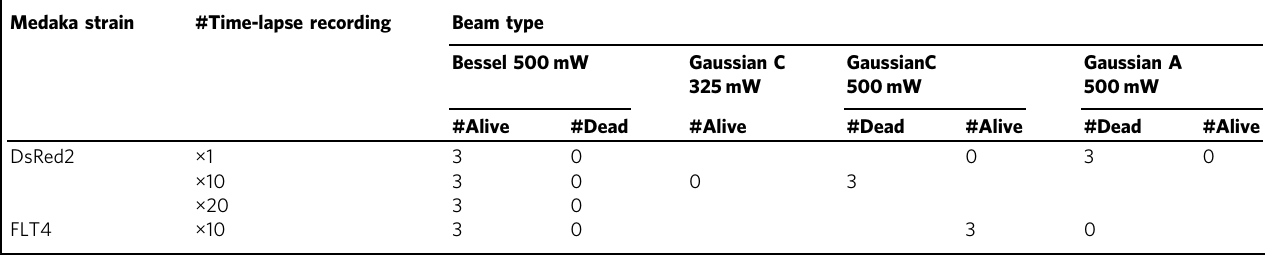
Table 1 Survival of embryos in phototoxicity experiments.